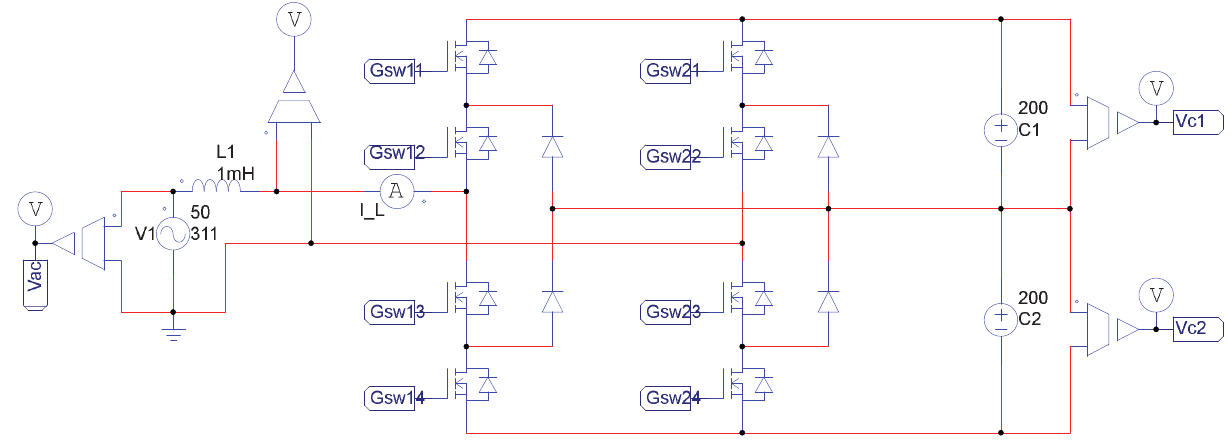
Fig. 4. Power part of the simulation model (ideal elements are